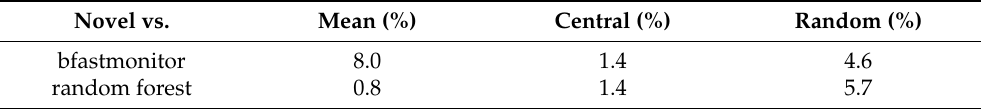
Table 3. Results of mean differences between localities when using the novel downsampling method versus the other downsampling methods. Positive values show the advantage of the novel downsam- pling method. Novel vs. Mean (%) Central (%) Random (%) bfastmonitor random